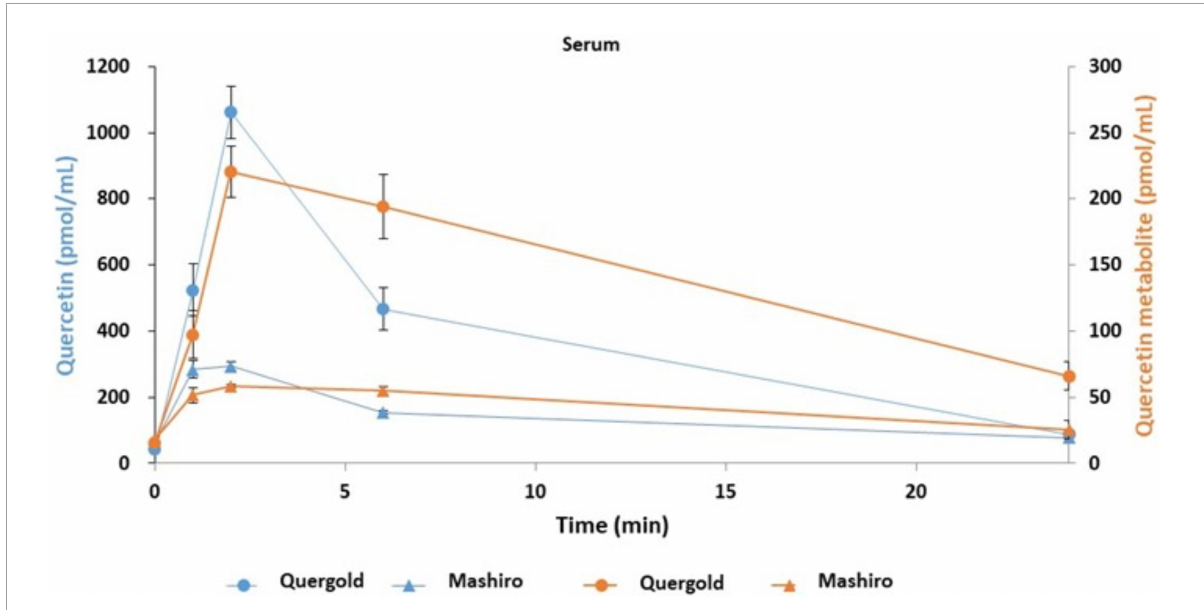
FIGURE5 Quercetin and its metabolites concentration in serum samples from human volunteers following ingestion of high and low quercetin content onion powders. The pharmacokinetics associated with onion powder containing two different concentrations of quercetin intake were also assessed to determine the quercetin concentration in serum samples. Serum concentrations of quercetin and its metabolite in healthy volunteer intaked a single 200 mg onion sample under fasting conditions. The circles indicate the serum of subjects with high quercetin (Quergold) intake, the triangles indicate the serum of subjects with low quercetin (Mashiro) intake. The distribution of quercetin and its metabolite shifted from serum to tear following onion intake. All data are presented as means ± S.D.